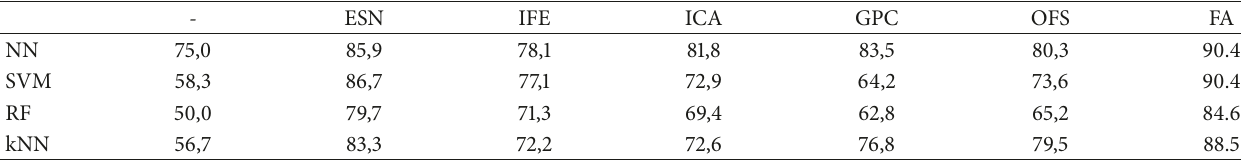
Table 1: Test Accuracy of 4 classifiers (NN, SVM, RF, and kNN) with feature selection methods: ESN: Echo State Network; IFE: Interval Feature Extraction; ICA: Independent Component Analysis; GPC: Graded Probabilistic Clustering; OFS: Optimal Feature Selection; Factor Analysis (FA).